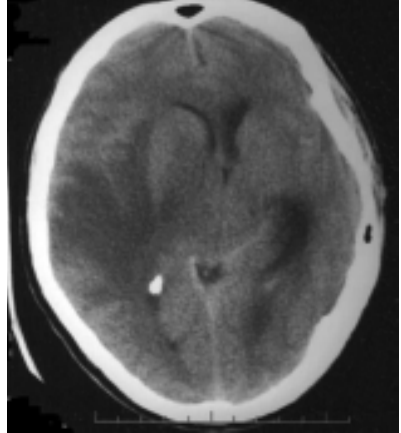
Fig. 1. Non-enhanced cranial CT shows a large low-density region in the right temporal lobe and severe midline shift. Compression of the right lateral ventricle and the brain stem can also be seen.